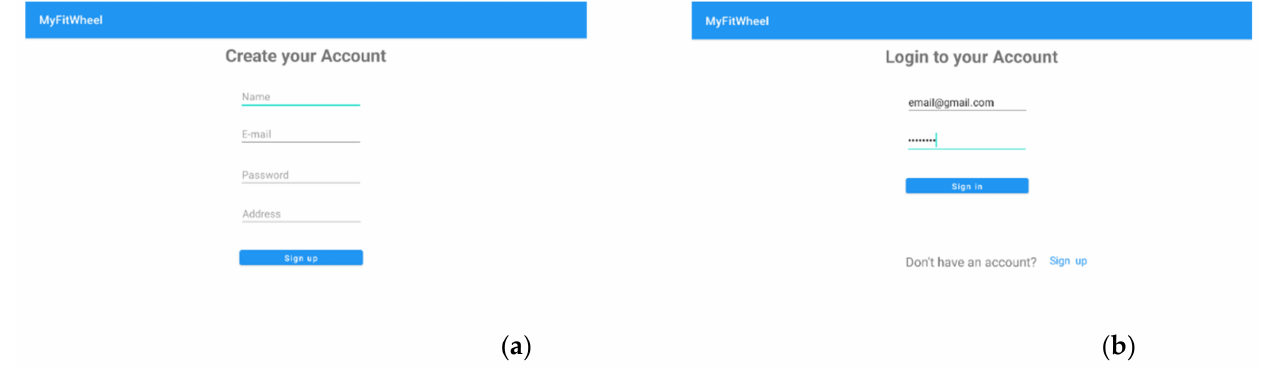
Figure 10. ( a ) Sign up tab on FIT-WHEEL app; ( b ) sign in tab on FIT-WHEEL app.